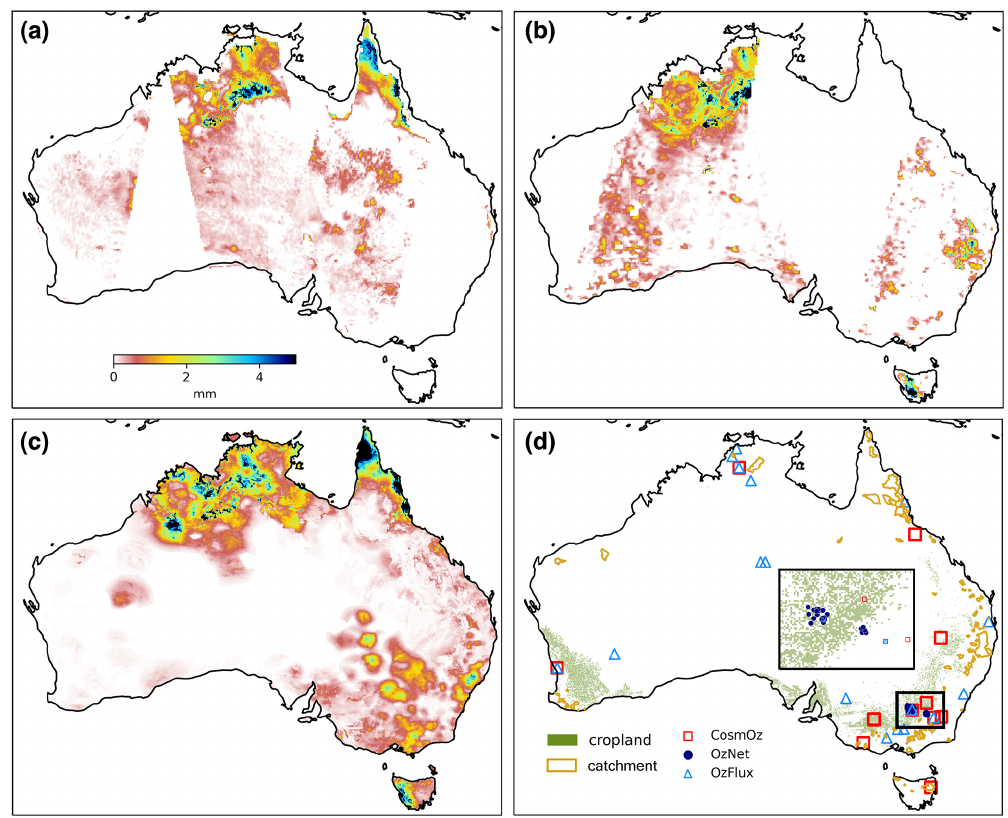
Figure 1. Satellite soil moisture retrievals in model unit (mm) for (a) SMAP and (b) SMOS compared to (c) AWRA-L estimates of surface soil water storage for 1 January 2019. (d) Locations of in situ soil moisture monitoring networks (CosmOz, OzNet and OzFlux), catchments for streamflow validation and grid cells classified as cropland. The rectangular inset map provides a zoomed-in view of the OzNet network region in south-eastern